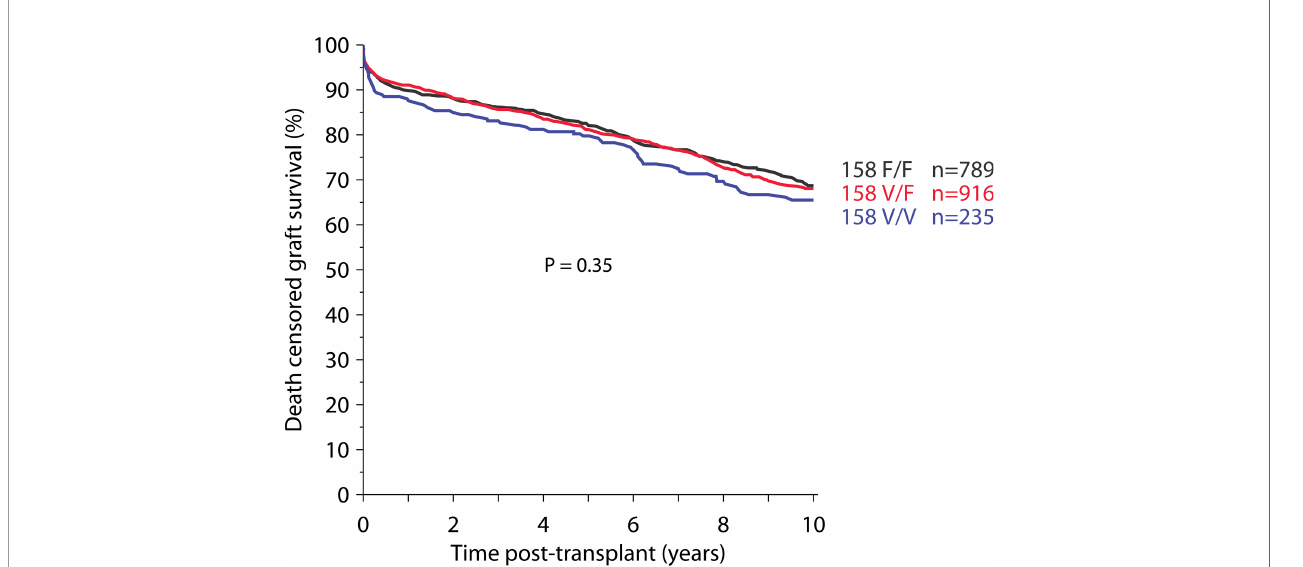
FIGURE 4 | Impact of donor-derived Fc g RIIIA polymorphism on death-censored graft survival (total 1,940